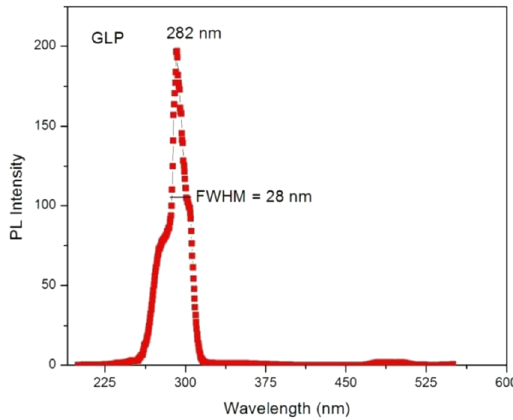
Figure 3. Emission spectrum of GLP.